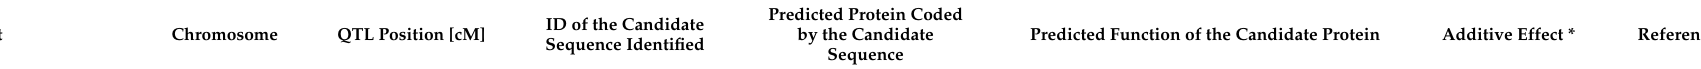
Table 1. Identified QTL regions, along with candidate genes in these regions and their predicted function, associated with abiotic and biotic stress tolerance as well as other important breeding traits in